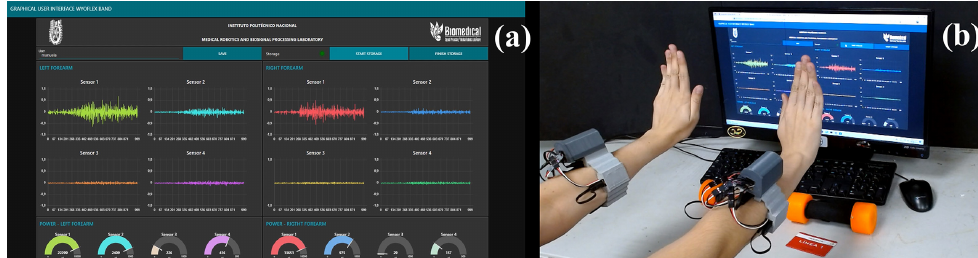
Figure 10. Example of the extension movement in the test protocol. ( a ) Visualization of the sEMG signals in the GUI, ( b ) Example of the extension